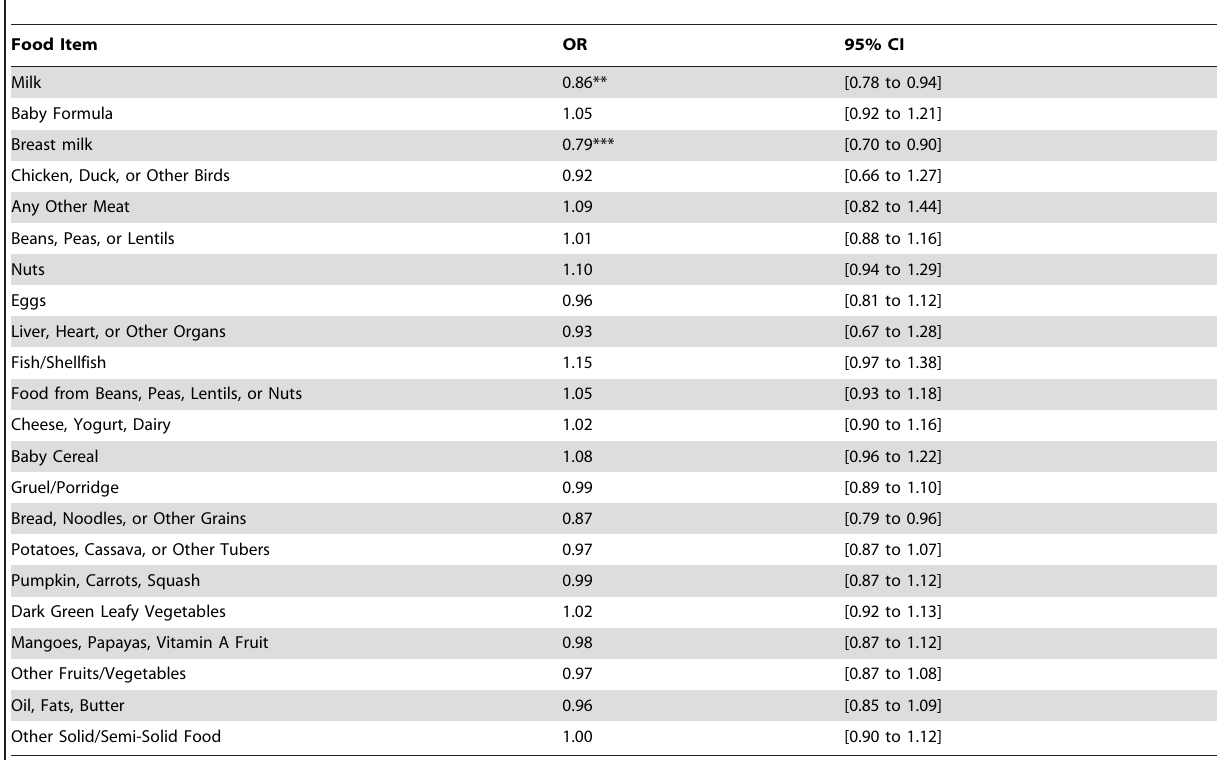
Table 3. Odds of specific food item consumption for females compared with males, living children aged 6–59 months, NFHS-3.